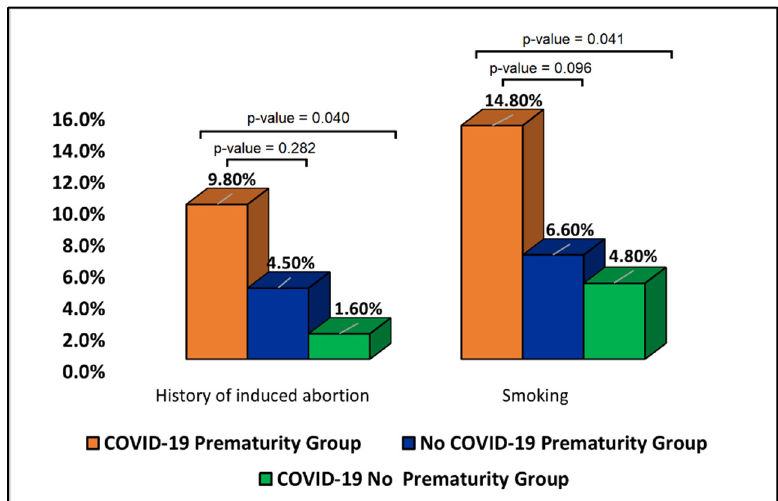
Figure 1. Proportions of patients with a history of induced abortion and smoking. Table 2. Patient